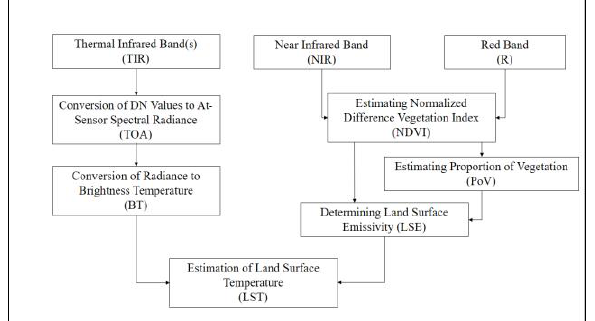
Figure 4. Working Methodology-Land Surface Temperature